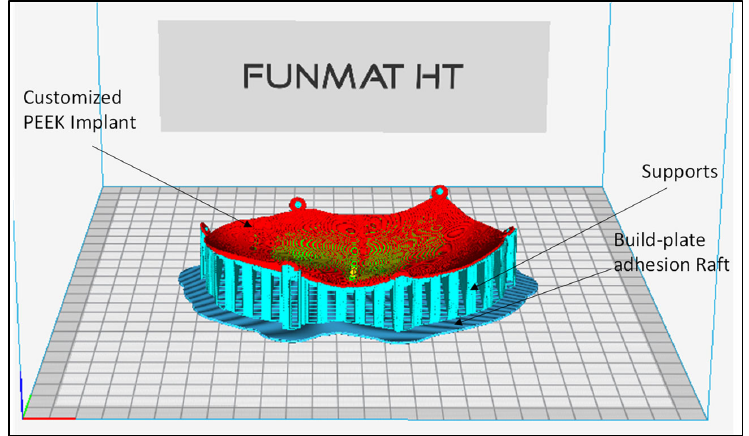
Figure 5. INTAMSUITE software for the orientation and support generation of the PEEK 3D model.